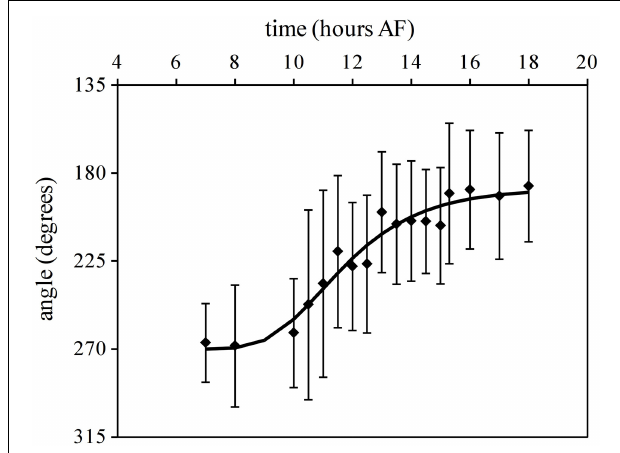
FIGURE 3 | Influence of reorientation on the fixation of direction and sense of polarization vector. Second order mean angles for the polarization vector after 90 ◦ reorientation. Upper and lower error bars are Mardia’s circular standard deviation for the mean angles ( n > 200 in three replicate experiments). The line depicts the regressed Gompertz sigmoid that best describes the data.